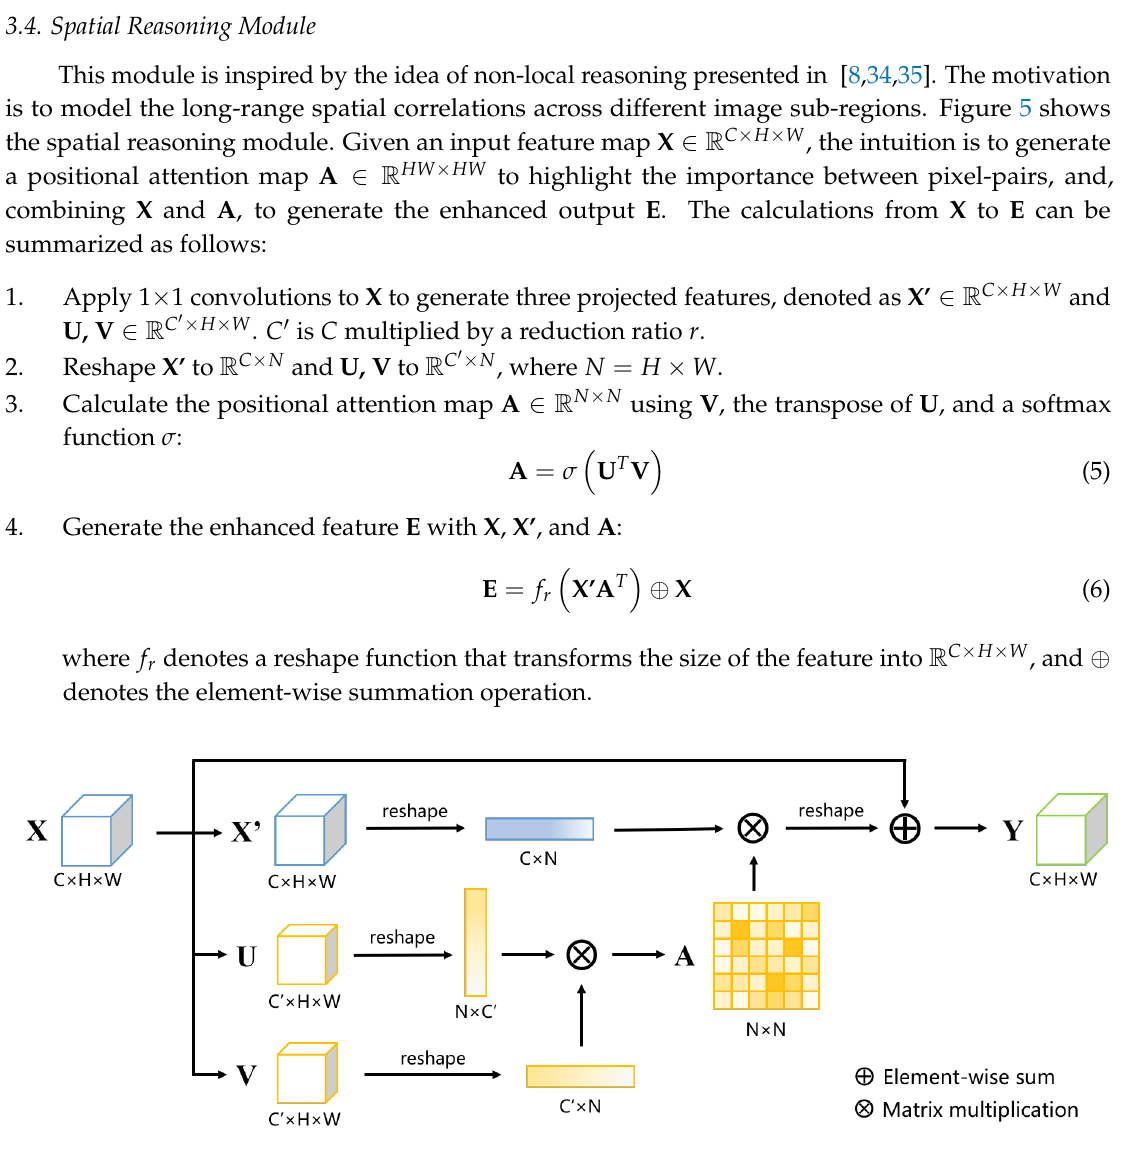
Figure 5. Detailed design of the spatial reasoning